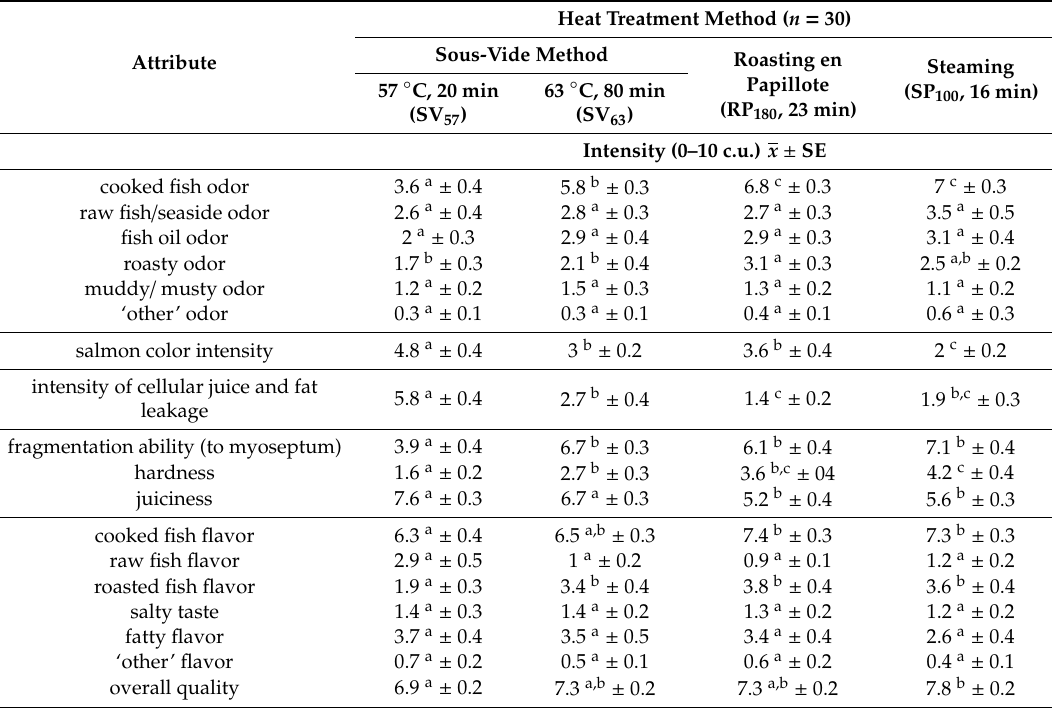
Table 3. Sensory profile of a salmon fillet processed with various heat treatment